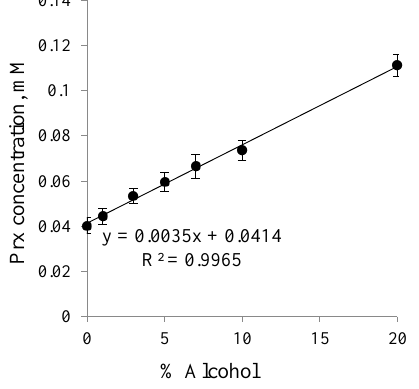
Figure 2. Solubility profile of piroxicam (Prx) in an ethanol–water system.